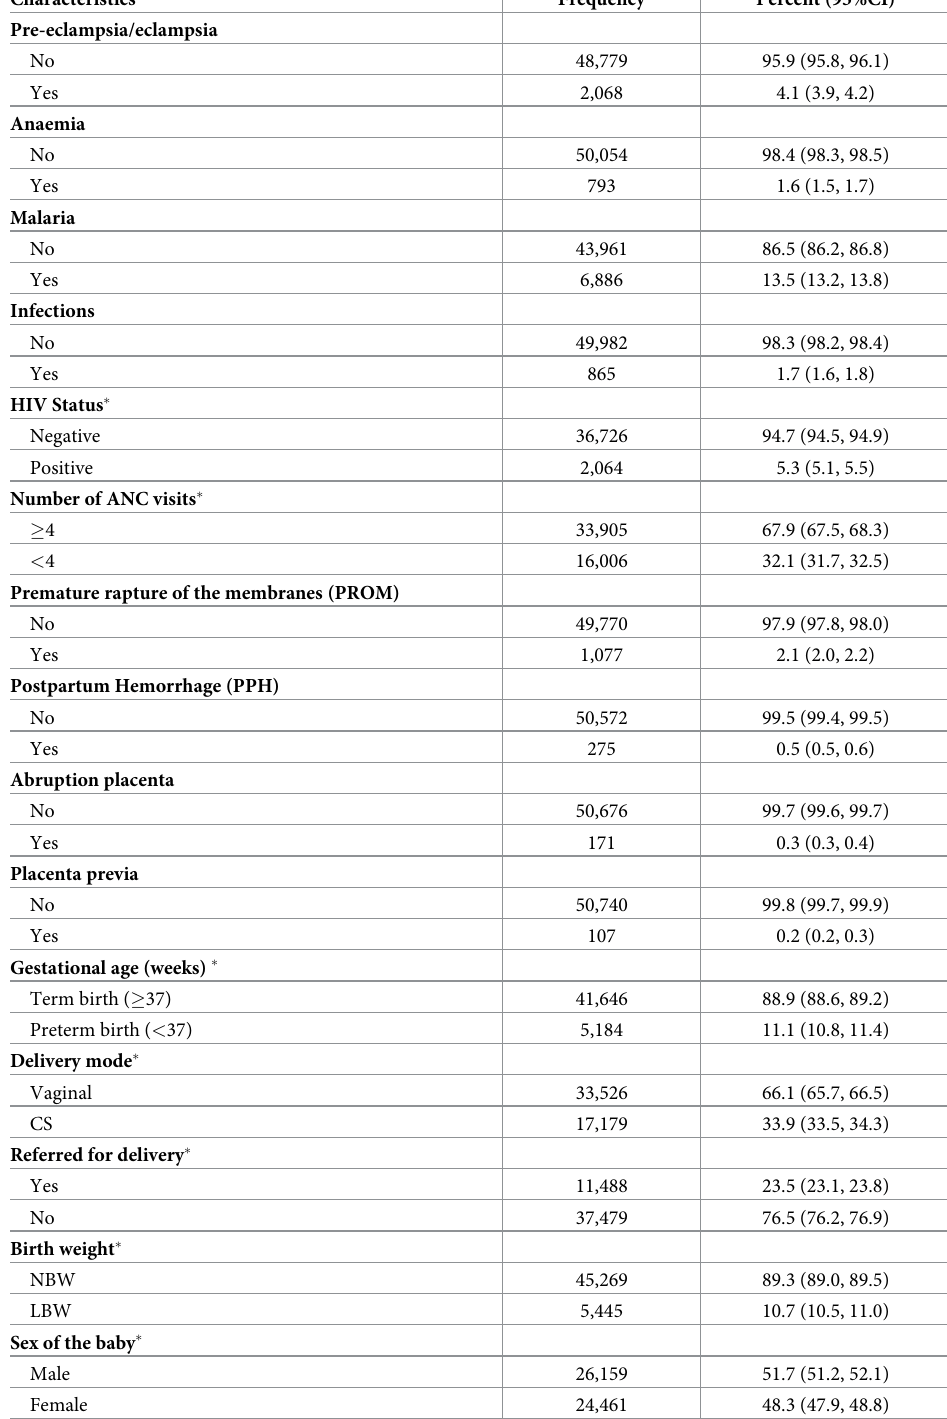
Table 2. Diseases and complications during pregnancy and delivery (N =